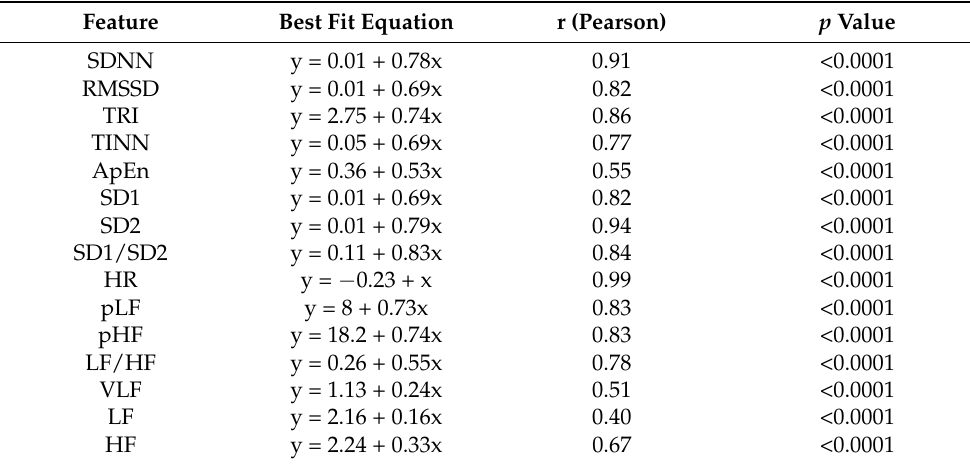
Table 4. Linear regression of HRV features versus PRV features.